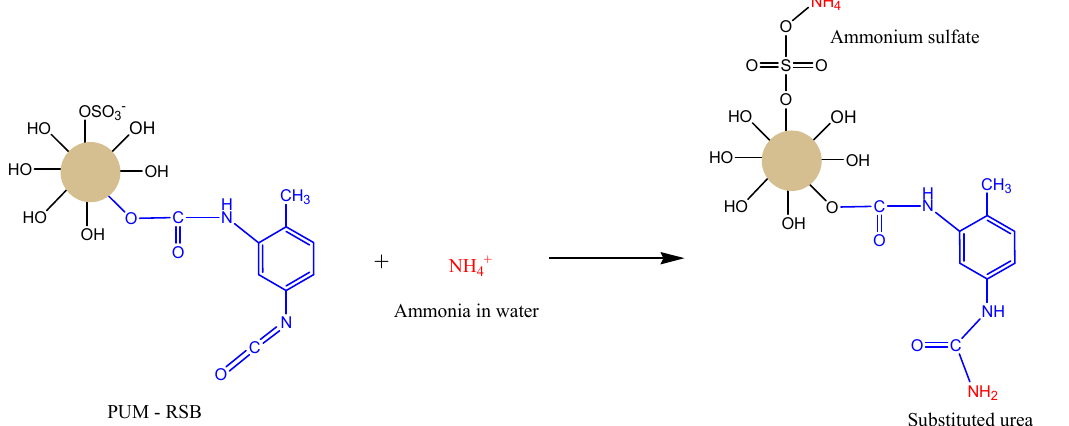
Figure 7. Interaction of ammonia in water by a PUM-RSB [23,24].